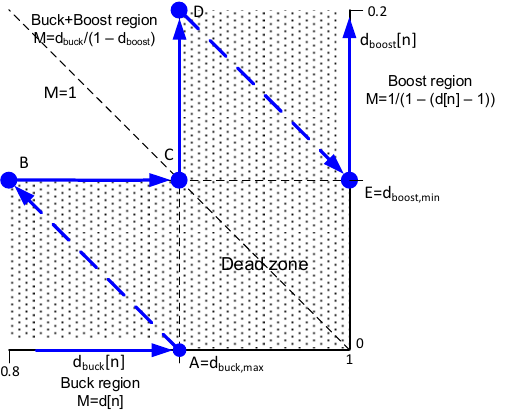
Figure 11. Trajectories defined by (d buck [n],d boost [n]) pairs to go from B to D considering d buck,max = 1–d boost,min .